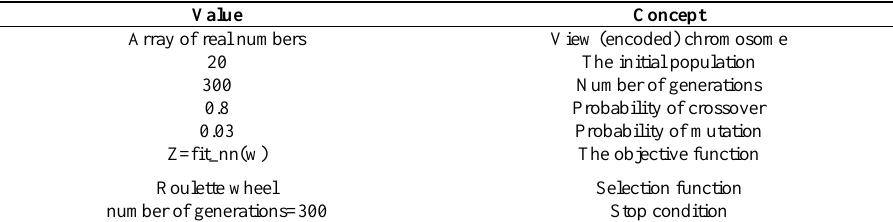
Table 2. Specification of (BP -